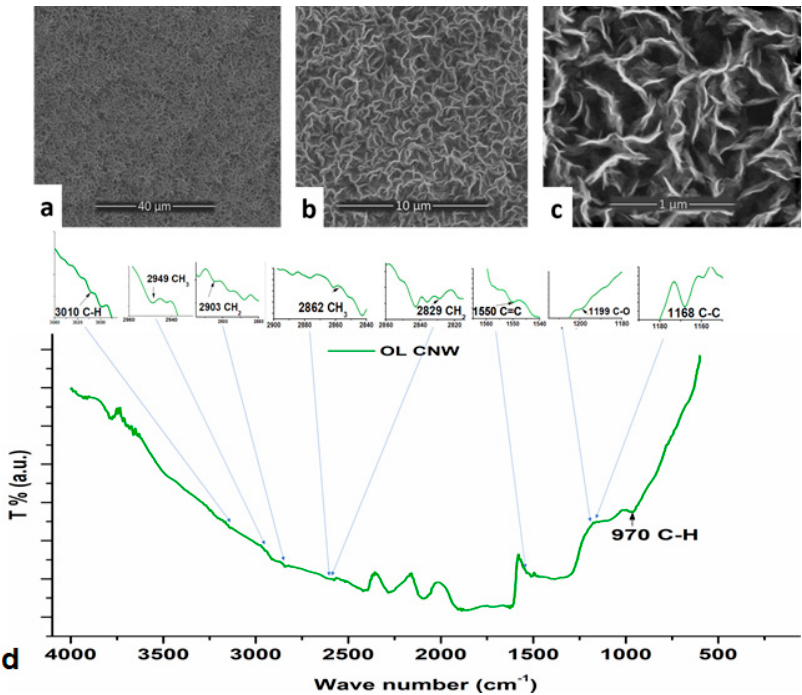
Figure 3. SEM images of carbon nano-walls deposition on K455 steel at different magnifications ( a – c ), and FT-IR spectra for OL/CNW ( d ).